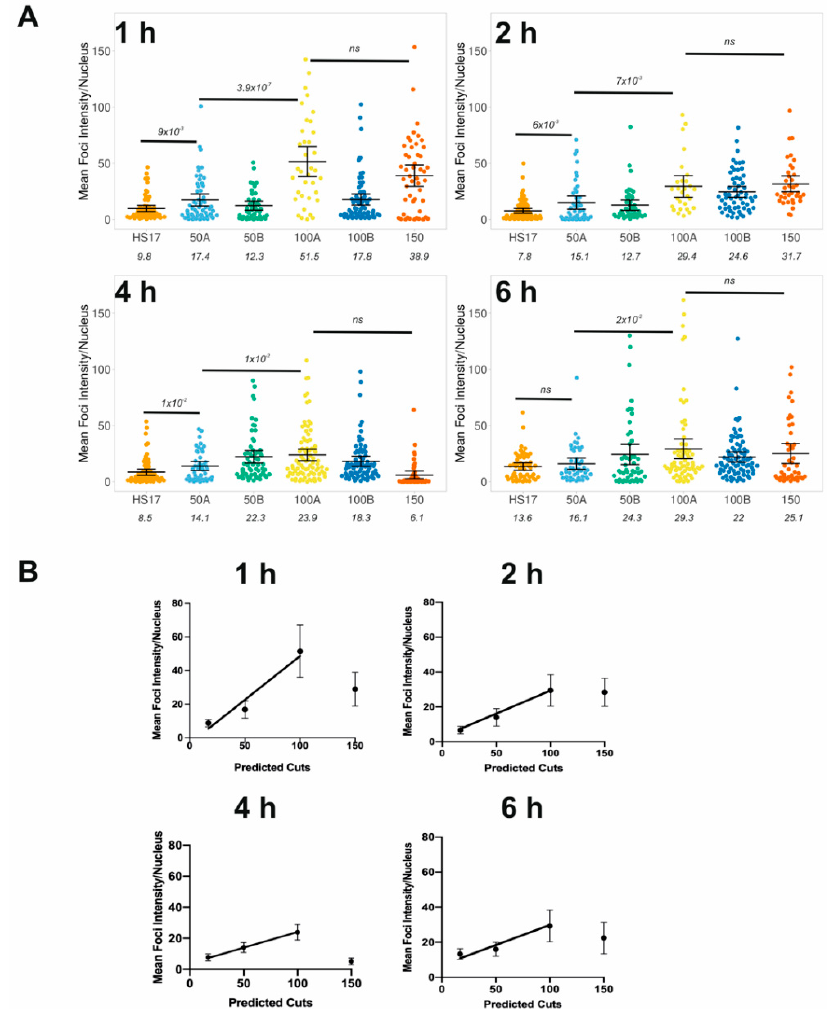
Figure 6. Correlation between the predicted number of cuts and γ H2AX fluorescence intensity . ( A ) Quantitative image analysis, as described in the Methods Section, from the experiments shown in Figure 2. The mean intensity per nucleus is plotted for each guide RNA. Each data point is an individual nucleus. The p -value is calculated from a two-tailed t -test and the error bars represent SD. The mean values are presented. The time refers to hours post-electroporation. ( B ) Linear correlation plots of mean intensity per nuclei following electroporation with guide RNA to induce 17, 50, 100 and 150 cuts. The bars represent the 95% CI. The data for 150 did not vary across the time course so it was removed from the correlation fitting.